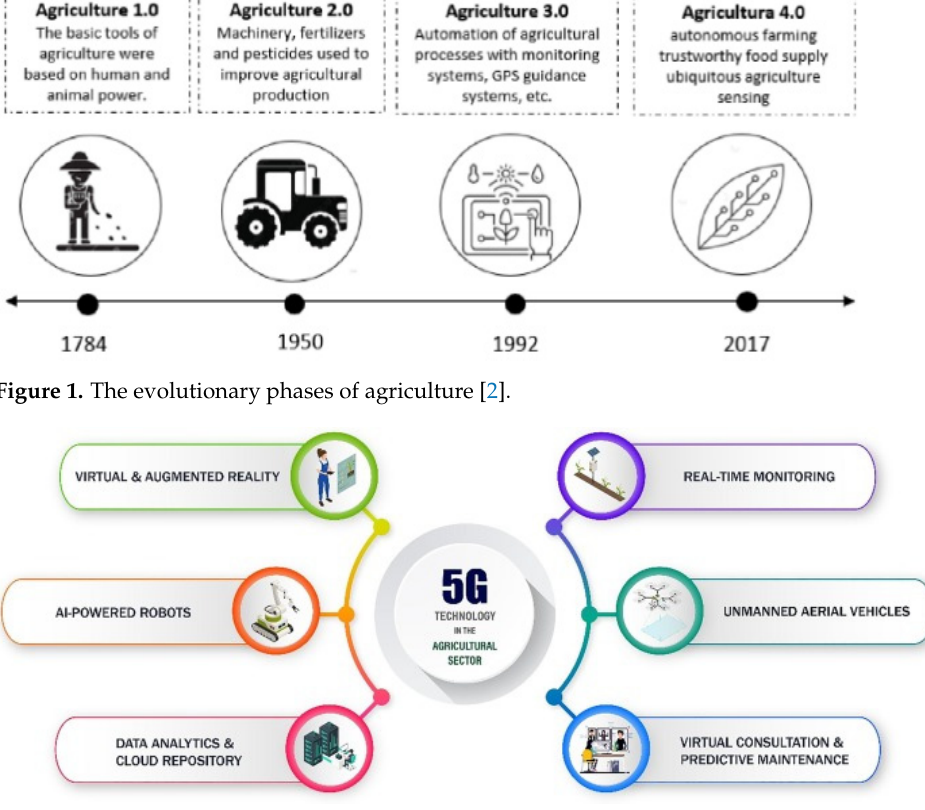
Figure 2. 5G technology in the agriculture sector [4], copyright permission: License Number: 5411150959041; License date: 17 October 2022; Licensed Content Publisher: Elsevier.